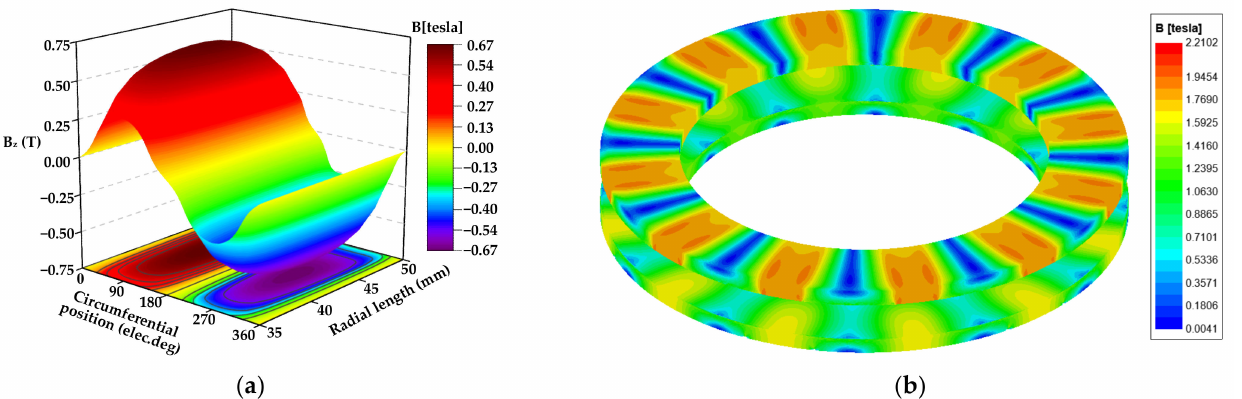
Figure 5. ( a ) 3D no-load air gap flux density distribution by FEA; ( b ) magnetic flux density distribu- tion of the AFPM machine.